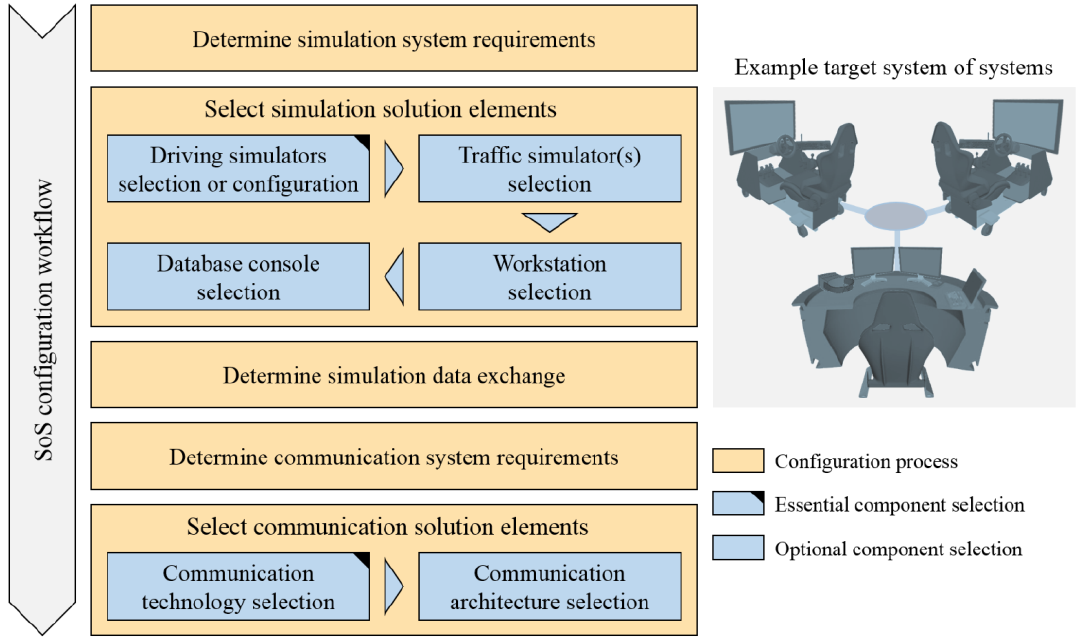
Figure 10. System configuration workflow and selection sequence of system components.